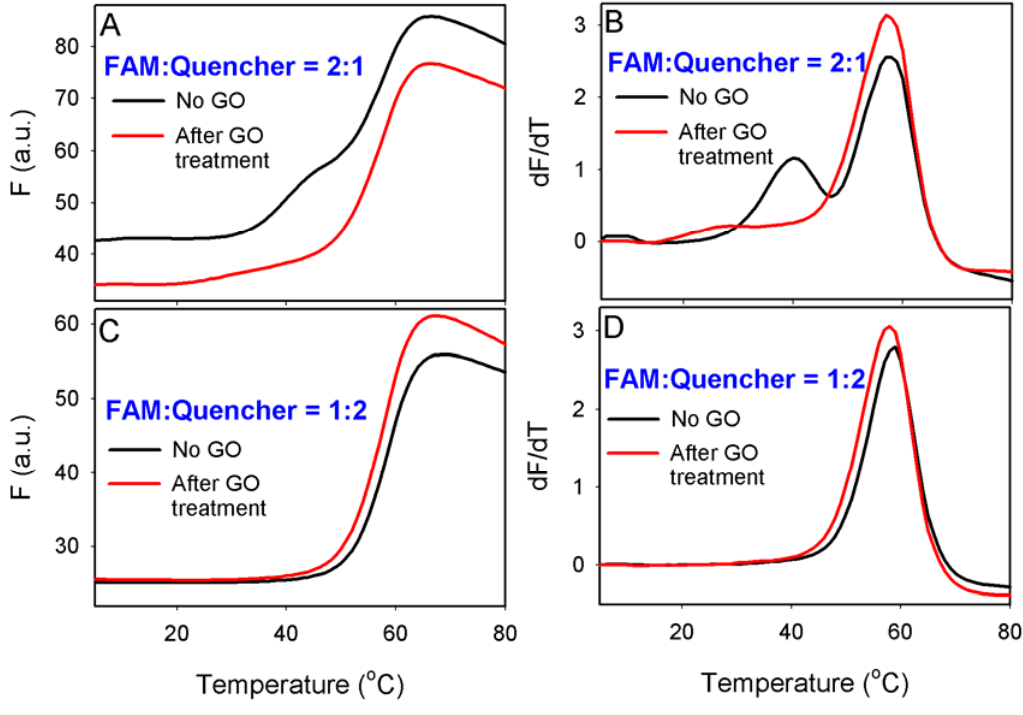
Figure 4. Melting curves ( A ) and its first derivative ( B ) for DNA duplexes made with the FAM-labeled DNA in excess. Melting curves ( C ) and its first derivative ( D ) for DNA duplexes made with the quencher-labeled DNA in